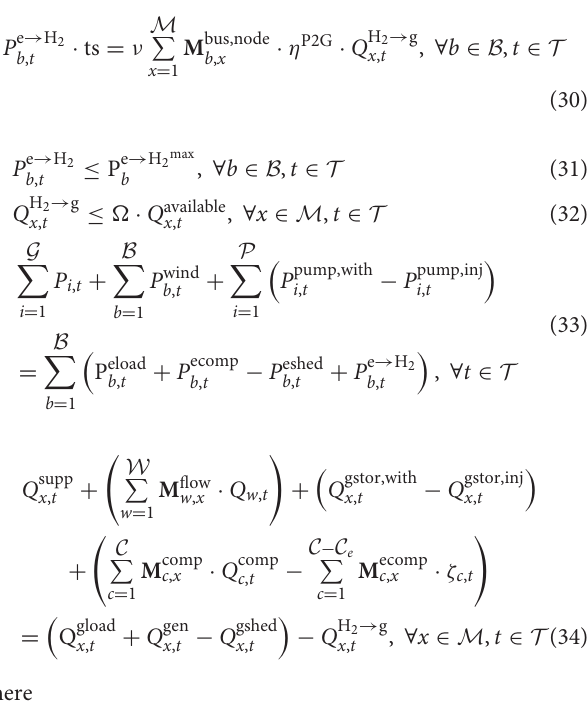
M bus.node bus-node incident matrix of busbar b and node x b , x 2max maximum capacity of electrolyser at busbar b P e → H b